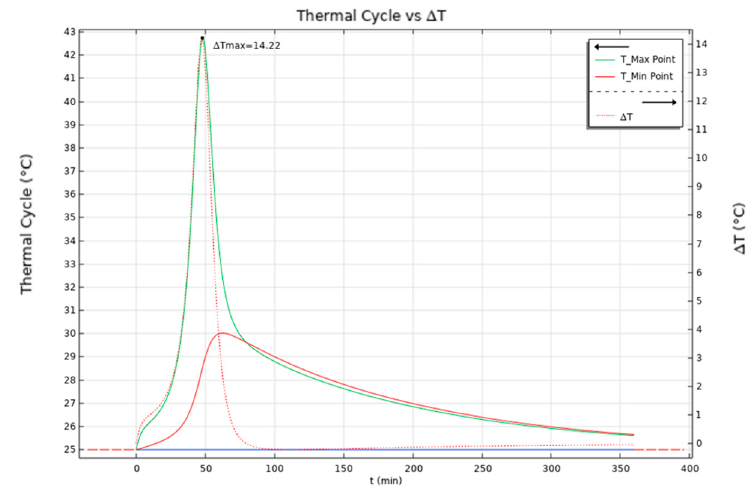
Figure 4. Temperature profile inside the part for the hottest and coldest points and their gradient for the cycle at Tmax equal to 25 °C. the cycle at Tmax equal to 25 ◦ C.